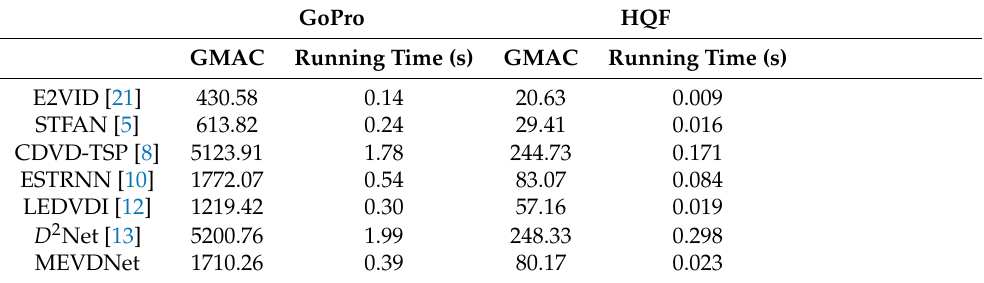
Table 6. GMAC and running time for the GoPro [22] and HQF datasets